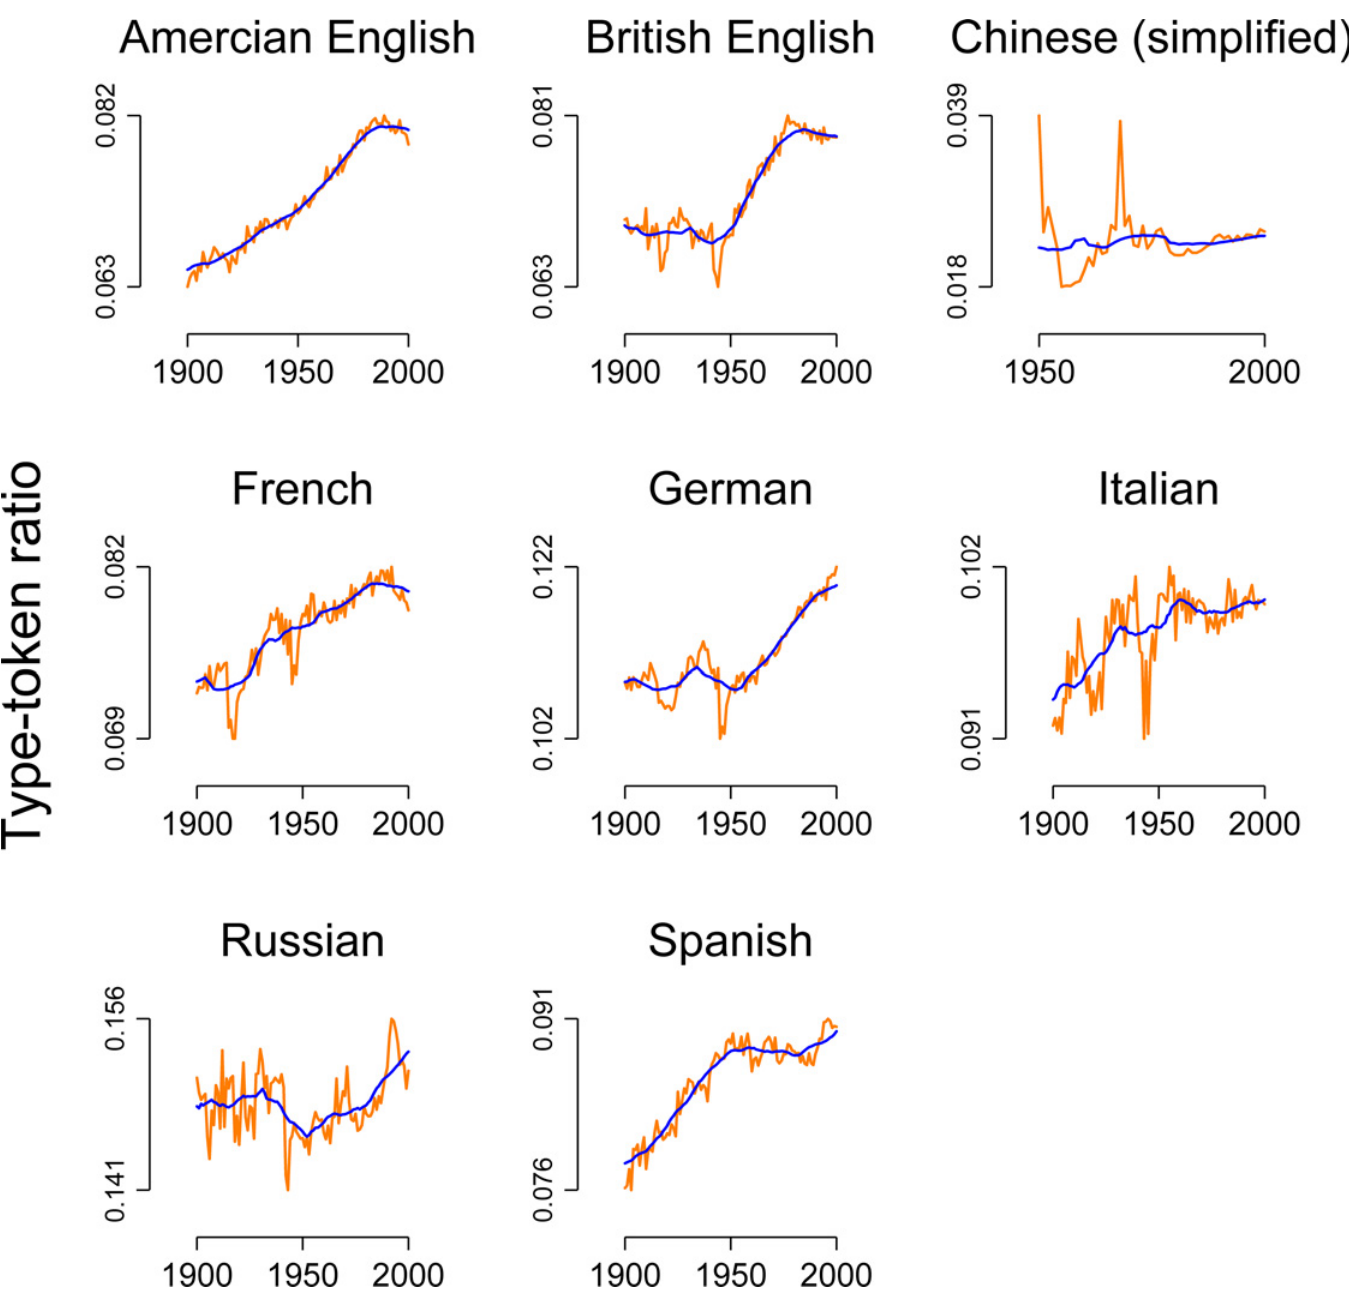
Fig 3. Type-token ratio as a function of time for eight languages (including two varieties of English). Orange lines: raw data. Blue lines: simple weighted moving average with an 11-year window centered on the current value.